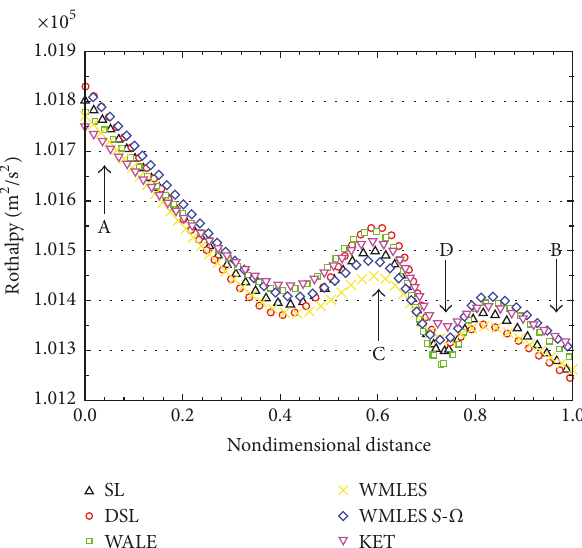
Figure 4: Changes in Rothalpy for different subgrid models.